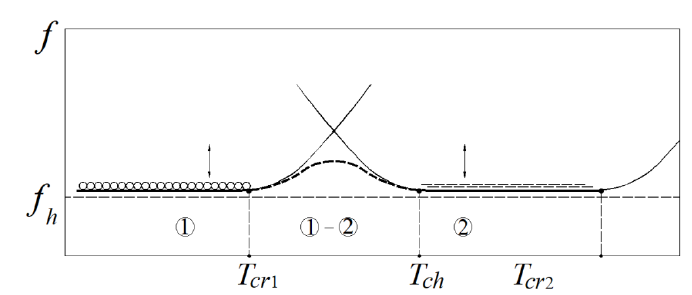
Fig.1. The kinetics of the formation of transition